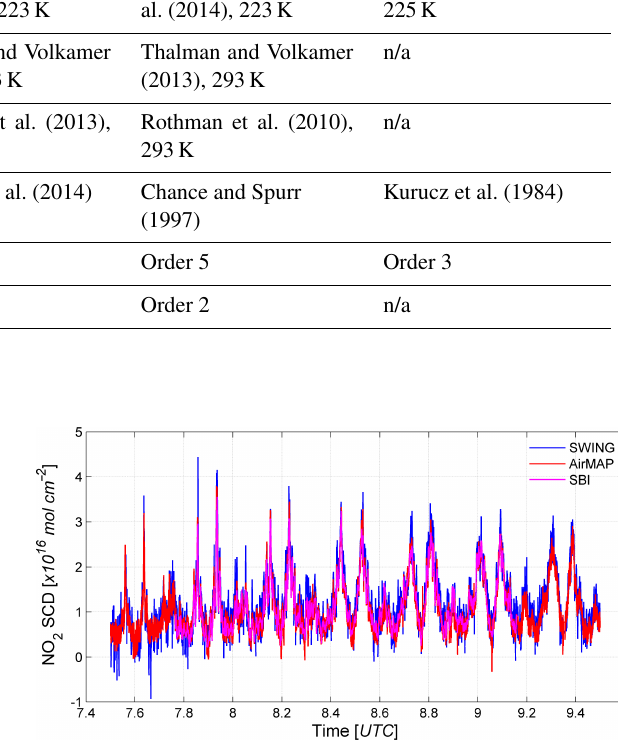
Figure 3. Time series of averaged NO 2 near-nadir SCDs ( > − 4 and < 4 ◦ VZA), retrieved from AirMAP, SWING, and SBI observations, during the morning flight over Berlin on 21 April 2016.